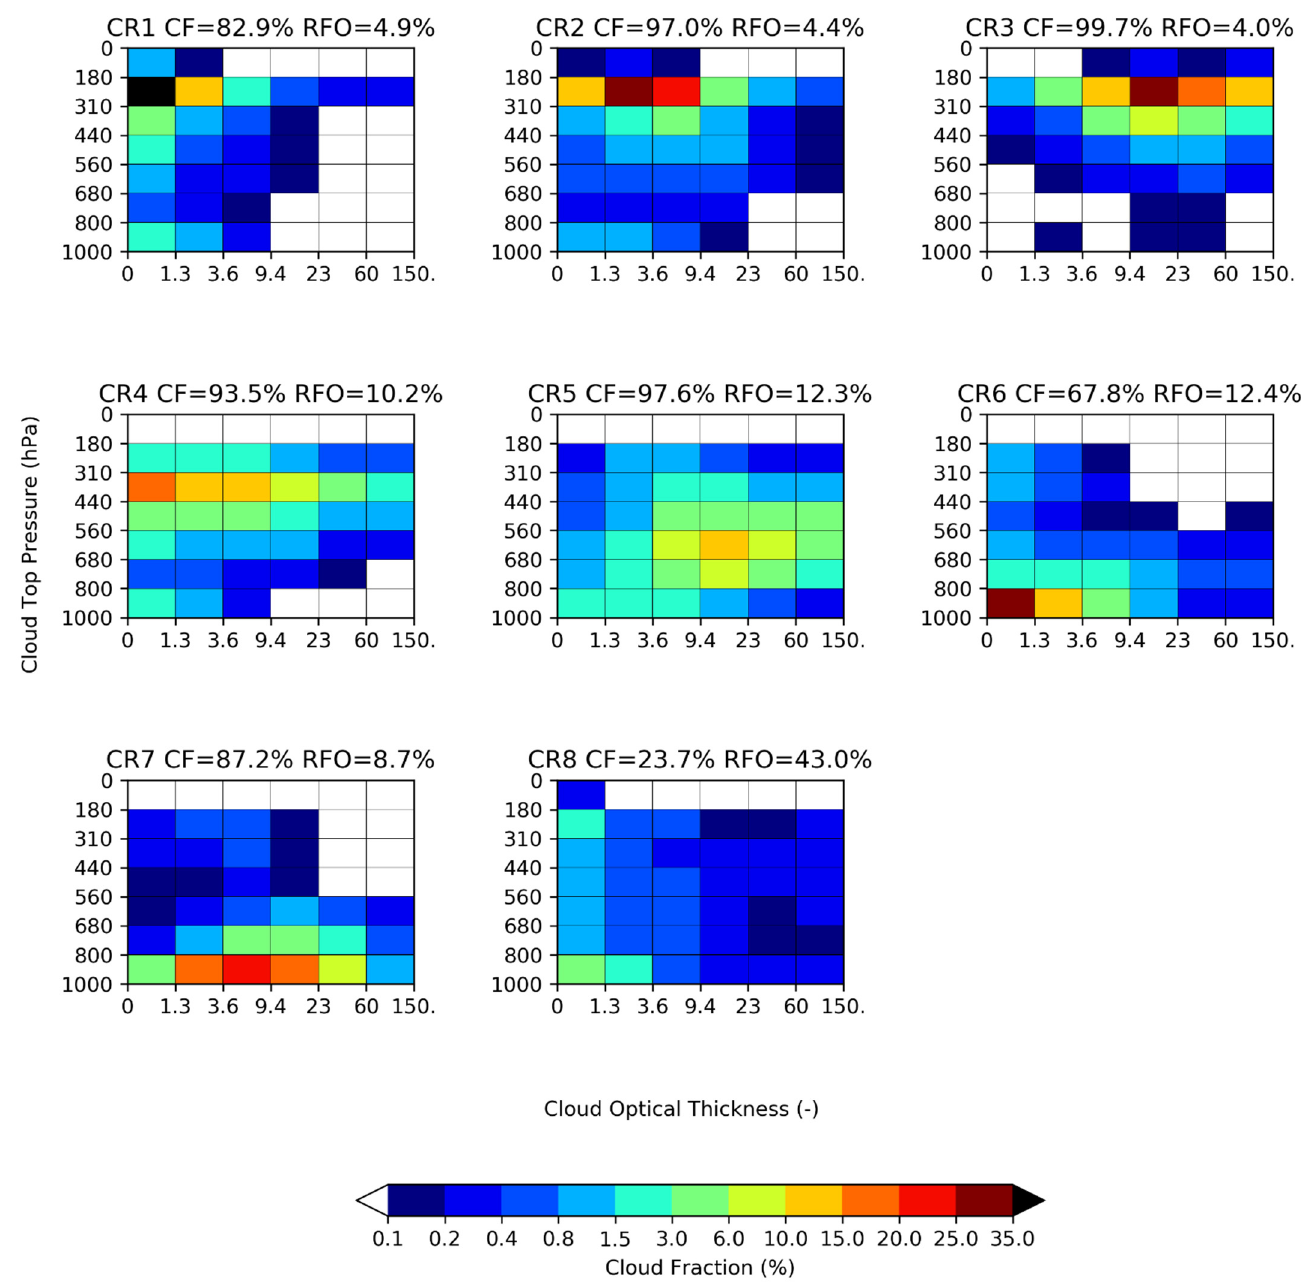
Figure 1. Centroids of the 8 CRAAS cloud regimes (CRs). The CRs were derived over Europe during the 2004–2017 period. On top of each centroid the total cloud fraction (CF) and the overall mean relative frequency of occurrence (RFO) is shown.